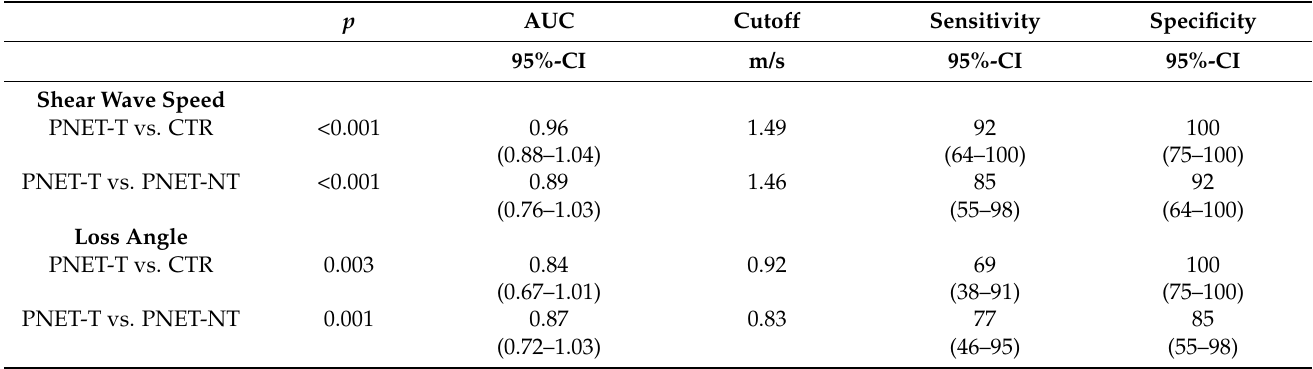
Table 3. Metrics of diagnostic